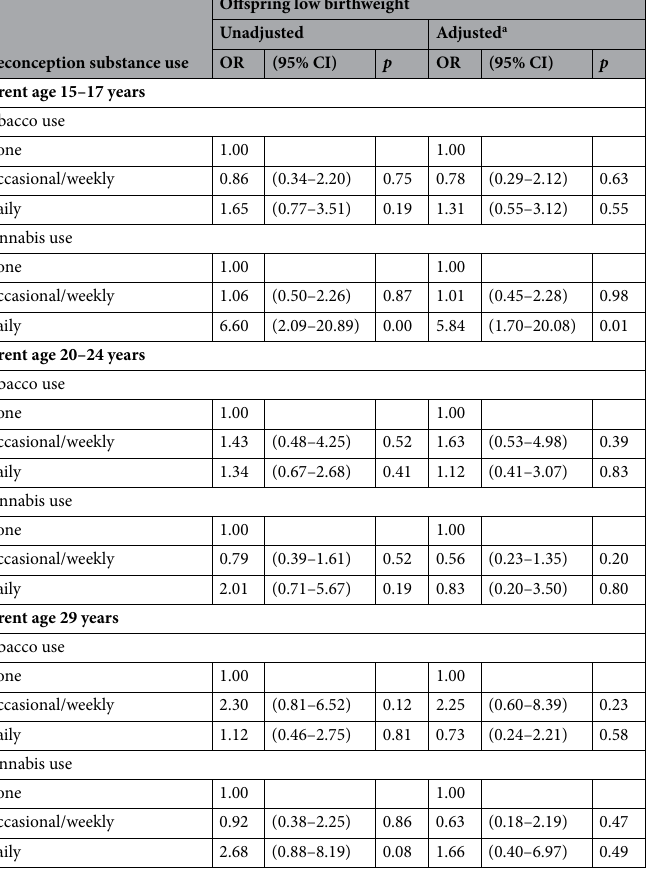
Table 3. Logistic regression analysis of relationship between tobacco/cannabis use frequency at age 15–17, 20–24 and 29, and low birthweight in 1030 children born to 665 parents (OR = odds ratio, CI = confidence interval). a All adjusted models adjusted for baseline/adolescent covariates: parent sex, offspring sex, family SES, grandparent education level, grandparent smoking status, adolescent mental health, and concurrent use of cannabis for models where tobacco is the exposure and vice versa. Adjusted models at age 20–24 years also include adjustment for frequency of use of the substance at age 15–17 years. Adjusted models at age 29 years models also include adjustment for frequency of use of the substance at age 15–17 and age 20–24